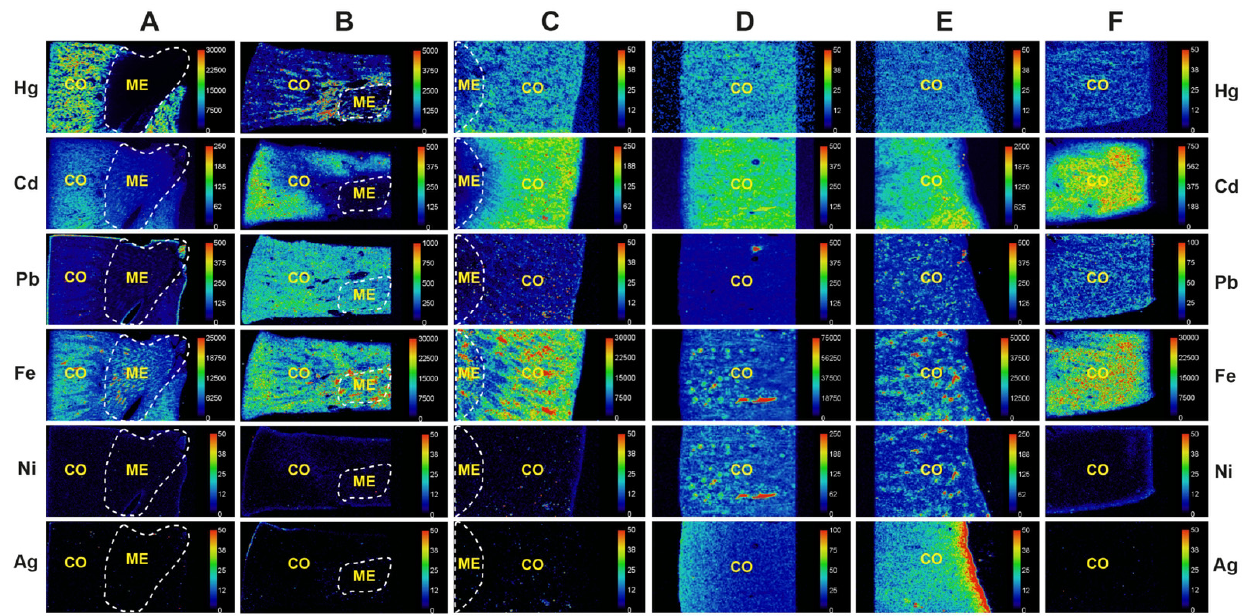
Figure 5. LA-ICP-MS detection of metals in six kidney samples. ( A ) AMG+ve cortex and medulla (K16). Mercury is detected in the cortex but not the medulla. Cadmium is present in the cortex, and iron in the cortex and medulla. ( B ) AMG+ve cortex and medulla (K32). Mercury is seen in the cortex, but not in the medulla. Cadmium, lead, and iron are seen in the cortex, and lead and iron in the medulla. ( C ) AMG+ve cortex and medulla (K19). Mercury, cadmium, and iron are seen in the cortex, and iron in the medulla. ( D ) AMG+ cortex (K69). Mercury, cadmium, iron, nickel, and silver are present in the cortex. ( E ) AMG-ve cortex (K51). Mercury, cadmium, lead, iron, nickel, and silver (with edge effect) are seen in the cortex. ( F ) AMG-ve cortex (K39). Mercury, cadmium, lead, and iron are present in the cortex. Scale = counts per second (proportional to abundance). CO cortex, ME medulla (within dashed outlines), AMG autometallography, K identify number (see Table 1). Table 2. Metals detected by laser ablation-inductively coupled plasma-mass spectrometry (LA-ICP-MS) in six human kidneys. ID Site AMG LA-ICP-MS Hg Cd Pb Fe